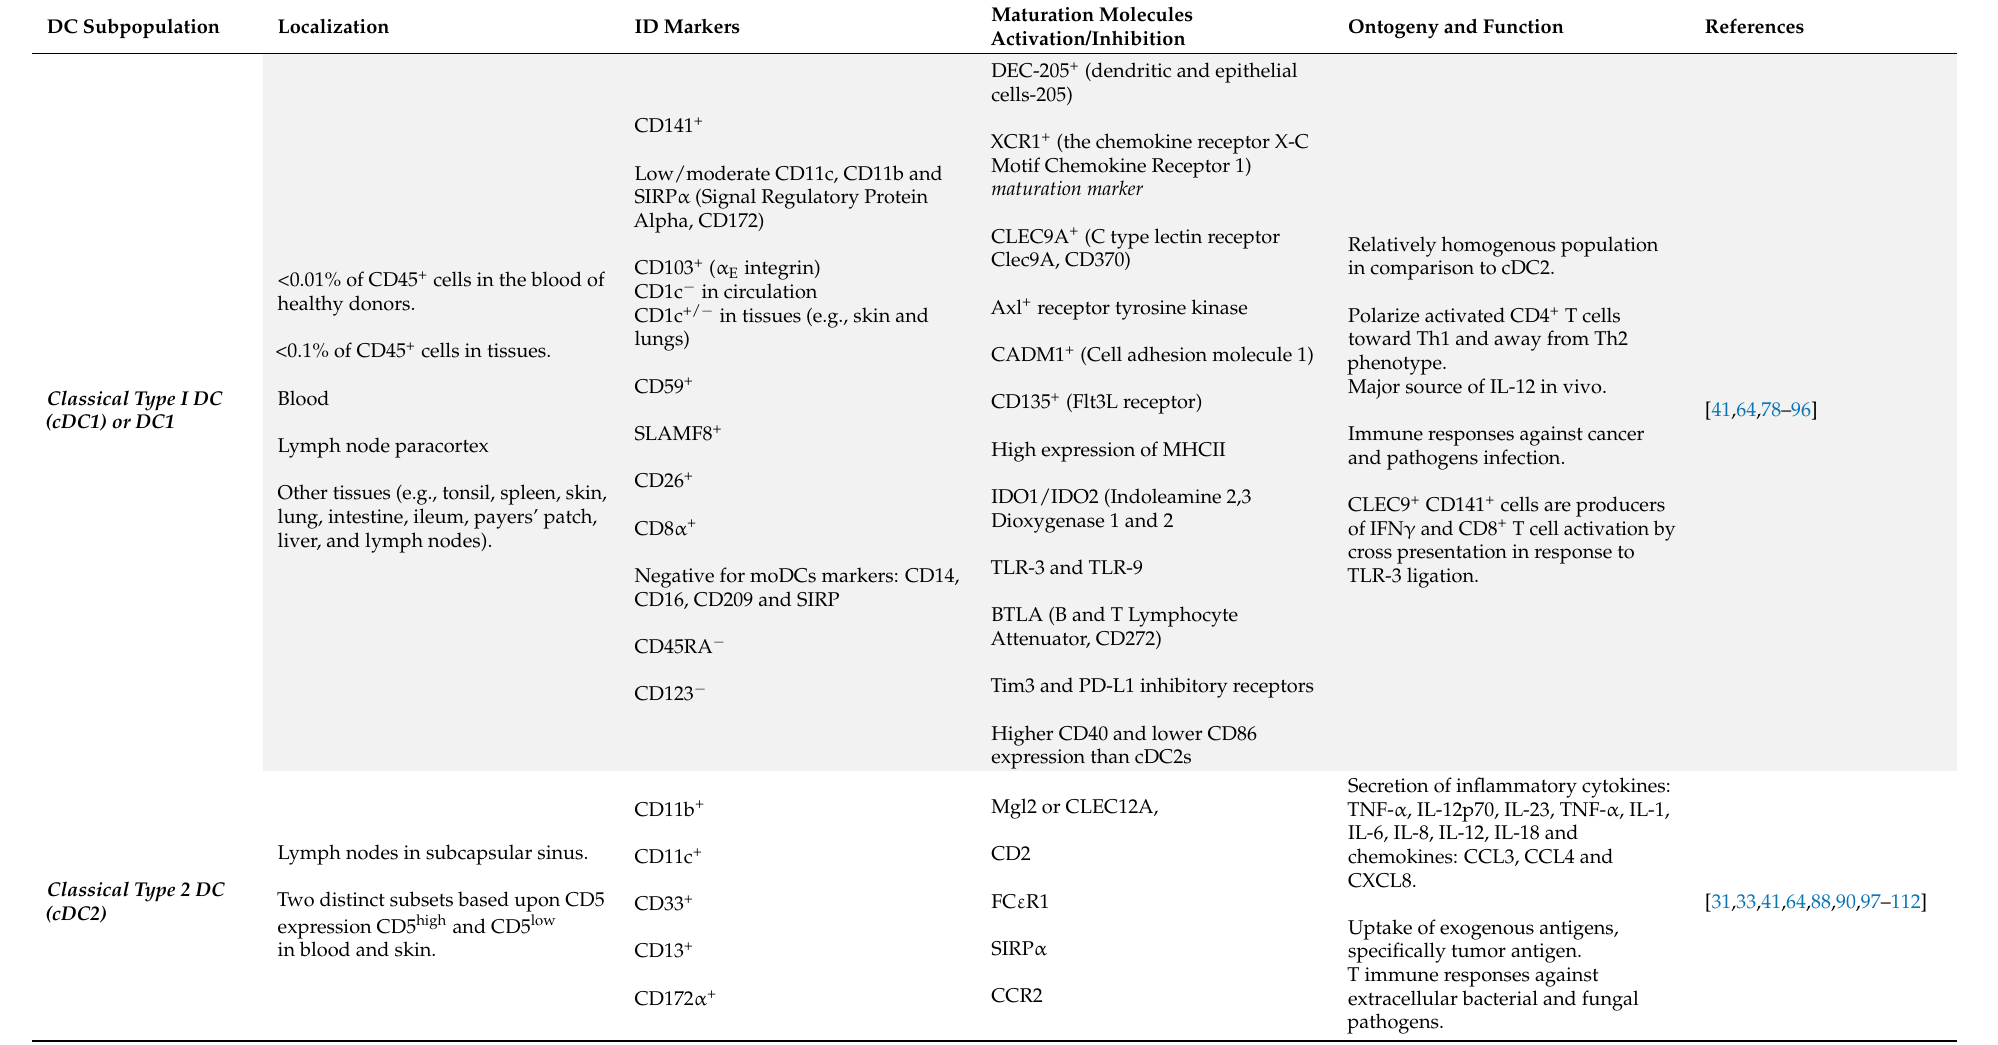
Table 1. Described functions of DC subpopulations in normal